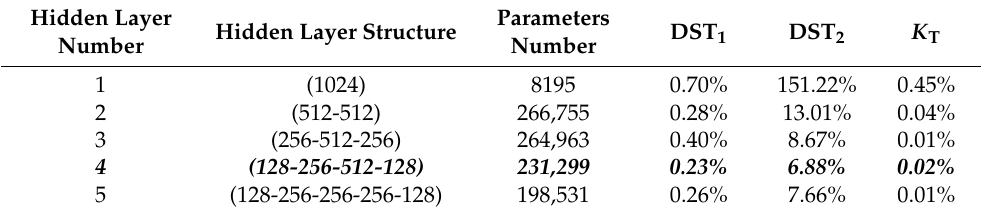
Table 1. Predictive error of different hidden-layer depths of the outputs.